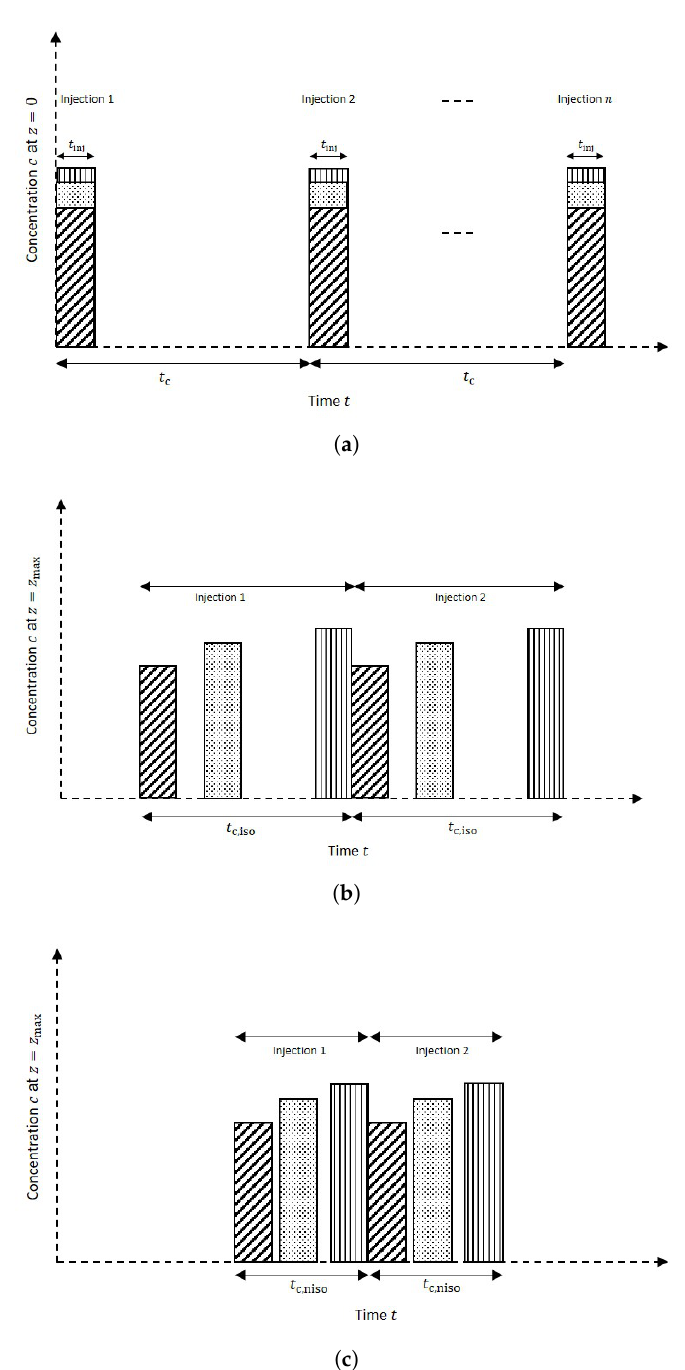
Figure 2. ( a ) Illustration of a mixture of three components having three different Henry constants, periodically injected at z = z 0 = 0. The cycle time is denoted by t c . ( b ) Effluent concentrations at z max for isothermal conditions and corresponding cycle time t c,iso (case “Late Eluter”). In this case the retention times of the first two components are significantly smaller than the retention time of the third component. ( c ) The same mixtures are injected using suitable segmented temperature gradients (non-isothermal operation). The pulses then elute closer to each other, leading to a reduction in the cycle time, that is, t c,niso < t c,iso